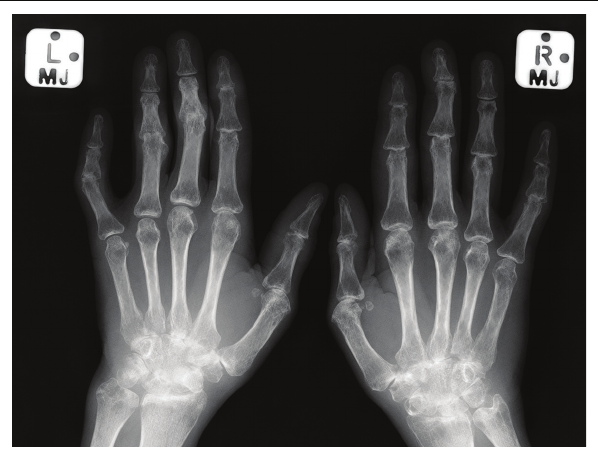
FIGURE 1: Frontal radiographs of both hands in an HIV-positive patient presenting with polyarthritis. RF was negative. Radiographs demonstrate bilateral severe peri-articular osteopaenia, severe joint space narrowing involving almost all joints and subluxation at the 3rd, 4th and 5th proximal interphalangeal joints.